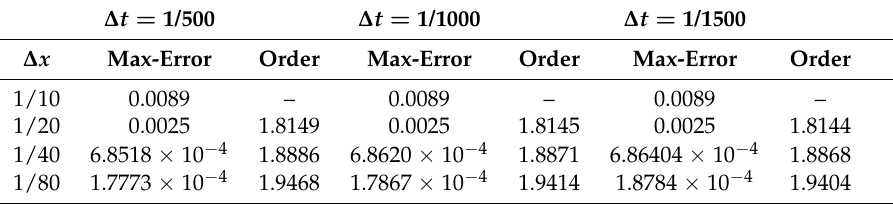
Table 1. Spatial convergence order taking fixed temporal step size with k = 0.1 and v = 1.